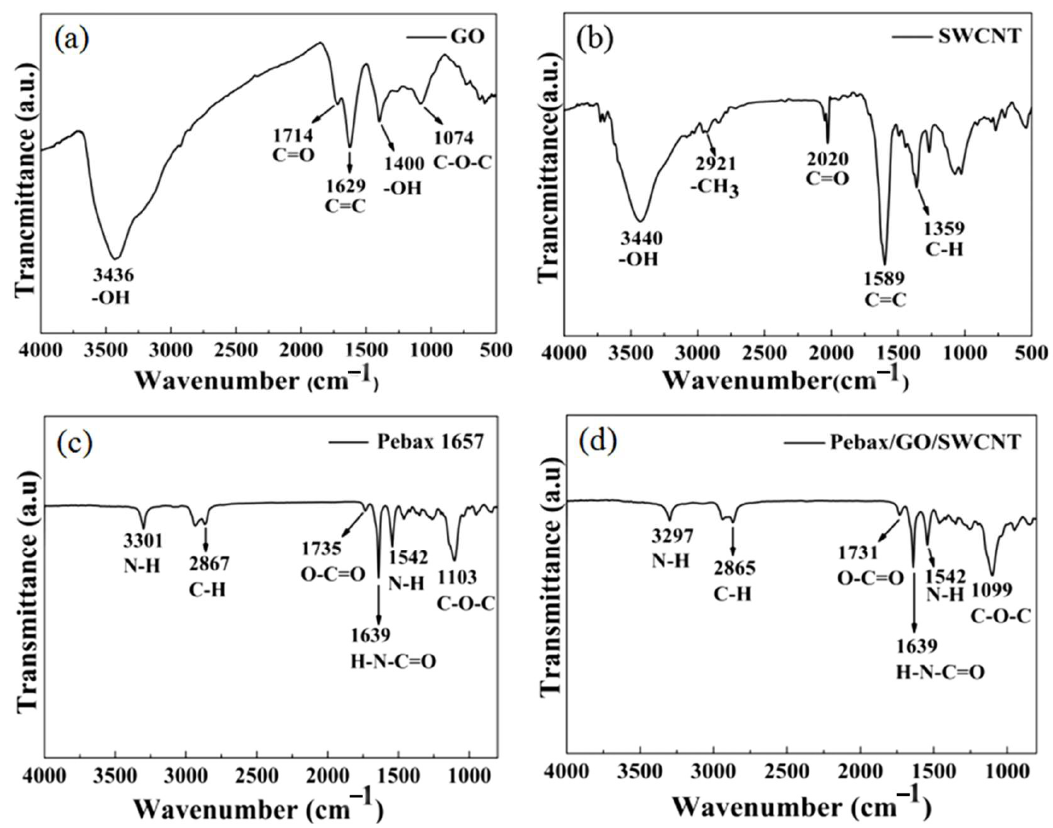
Figure 5. FTIR of ( a ) GO, ( b ) SWCNTs, ( c ) pure Pebax 1657, ( d )